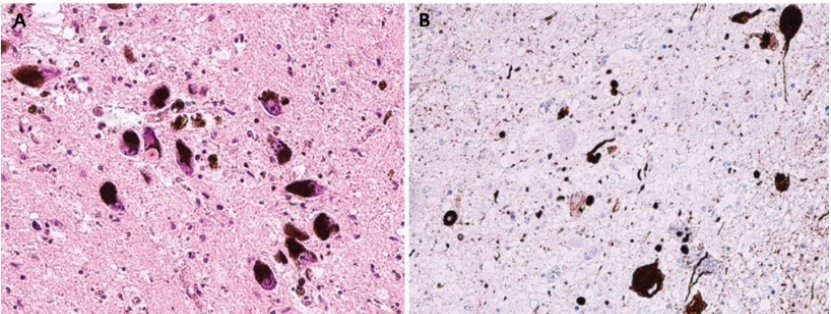
Figure 2. Neuropathological finding showing changes in Parkinson’s disease. ( A ) Lewy body in a pigmented neuron substantia nigra, H&E staining, original magnification 200×; ( B ) The spectrum of α -synuclein pathology in pons. Lewy bodies, neuronal granular cytoplasmic positivity and dystrophic neurites, stained with anti- α -syn monoclonal antibody, original magnification 200×.